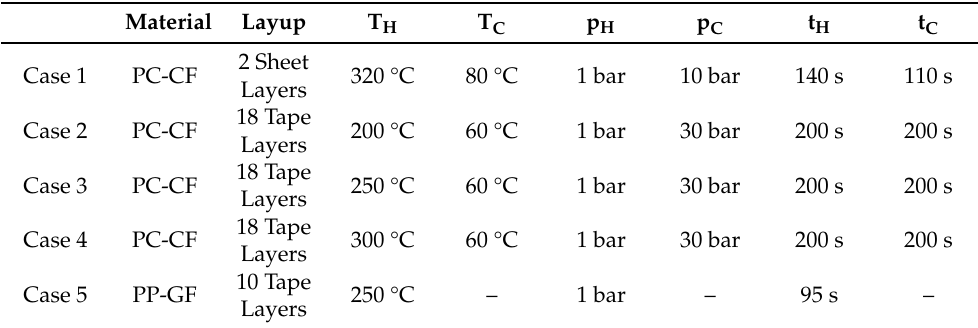
Table 3. Validation study process parameters: heating temperature (T H ), cooling temperature (T C ), heating pressure (p H ), cooling pressure (p C ) and cycle times for heating (t H ) and cooling (t C ) of polycarbonate with carbon fibers (PC-CF) and polypropylene with glass fibers (PP-GF). Material